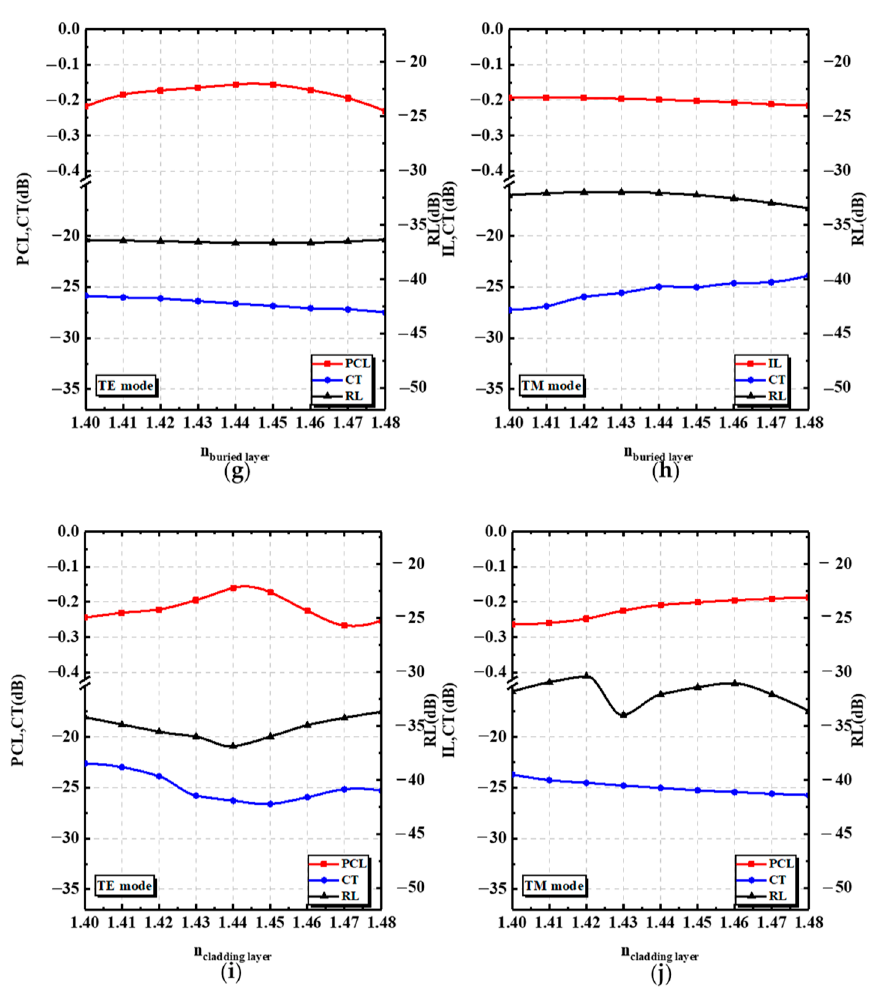
Figure 9. The analysis of the fabrication tolerance. ( a , c , e , g , i ) show the PCL, CT, and RL of the PSR with different W 5 , W 6 , H 1 , n buried layer , and n cladding layer deviations for the TE mode. ( b , d , f , h , j ) present the IL, CT, and RL with different W 5 , W 6 , and H 1 , n buried layer , and n cladding layer deviations for the TM mode.